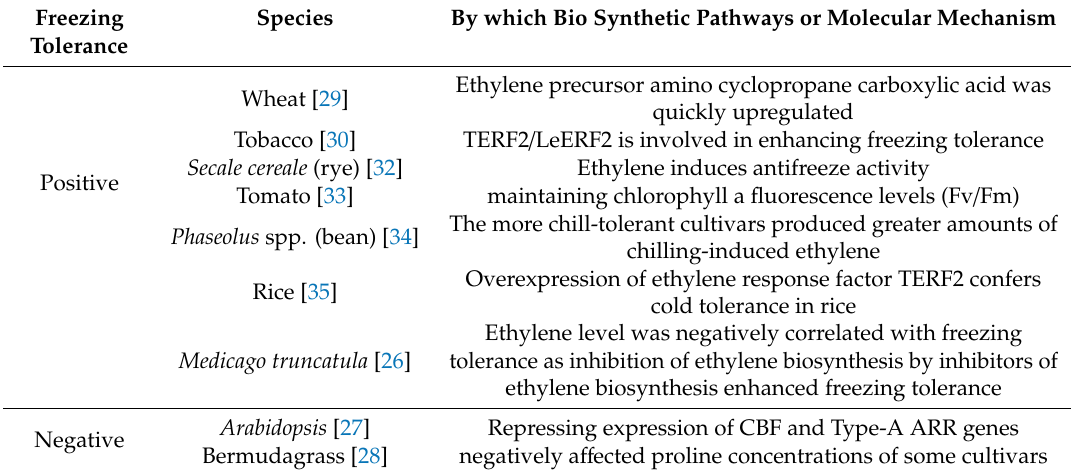
Table 1. Summaries of previous studies on the e ff ect of ethephon or ethylene on the chilling / freezing tolerance of